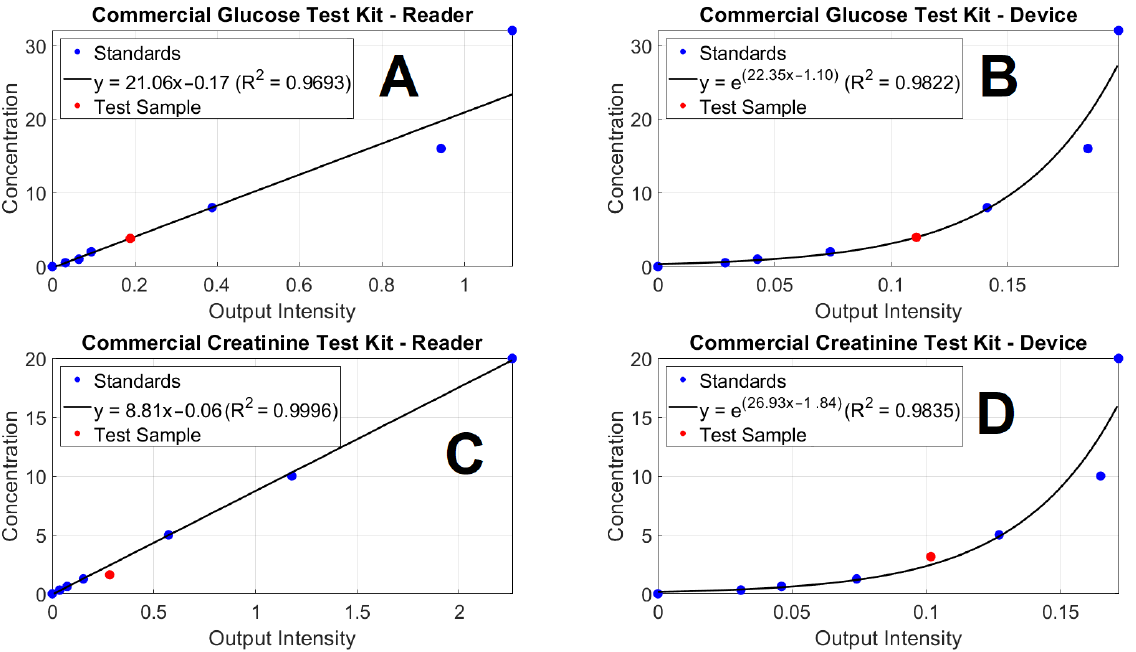
Figure 4. The unknown testing samples (red dot) are illustrated in the graphs of the standards from ( A , B ) glucose and ( C , D ) creatinine commercial test reagents, operated by ( A , C ) a microplate reader and ( B , D ) the developed device.